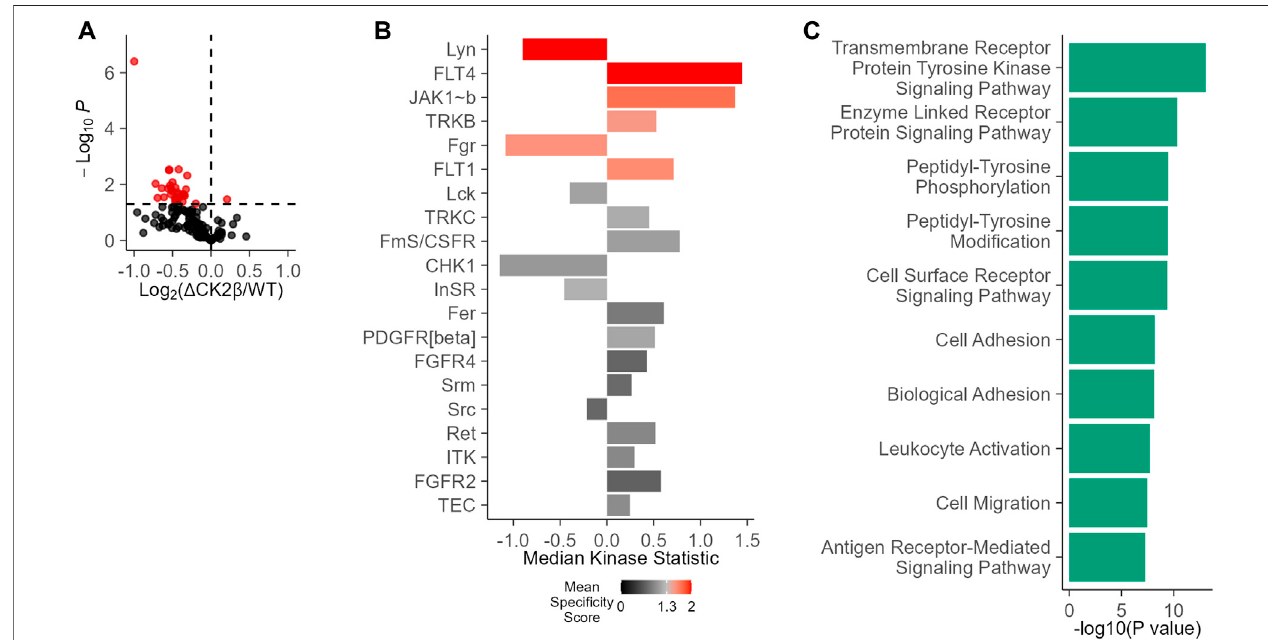
FIGURE 1 | Changes in PTK activity in Δ CK2 β MCF10A cells compared with WT cells. (A) Functional kinome pro fi ling using the PamChips, which contain multiple copies of individual peptides. Sequence-speci fi c tyrosine phosphorylation is detected by fl uorochrome-coupled phospho-speci fi c antibodies and CCD camera. The volcano plot visualizes the result of the tests by plotting, for each test, the effect size ( x -axis, LFC or delta) versus signi fi cance ( y -axis, – log10 ( p -value)) of the test. Red spots are peptides that show signi fi cant differences compared to control ( p < 0.05). (B) PTK score plot highlighting kinases that were modulated in Δ CK2 β MCF10A cells compared withWT cells.The plotshows resultsfrom theupstreamkinase analysis(UKA) tool,afunctionalscoringtool which rank-ordersthetopkinases that are differentially active between the two groups. The ranking factor is the fi nal (median) kinase score. This score is based on a combined sensitivity score (difference between “ treatment ” and “ control ” groups) and speci fi city score (for a set of peptides to kinase relationship derived from current databases). The kinase statistics indicates the group differences, with effect size (values) and direction (+ or > 0 = activation; – or 0 = inhibition). (C) Signaling pathways and biological process analysis